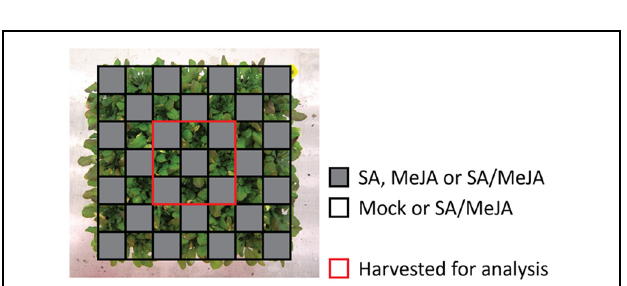
FIGURE 3 | Growth and fitness parameters of single- and double-attacked plants. Rosette diameter (cm), flowering time (days post inoculation), and total seed production (mg) of Arabidopsis plants. Plants were either inoculated with H. arabidopsidis (A) or infested with P. rapae